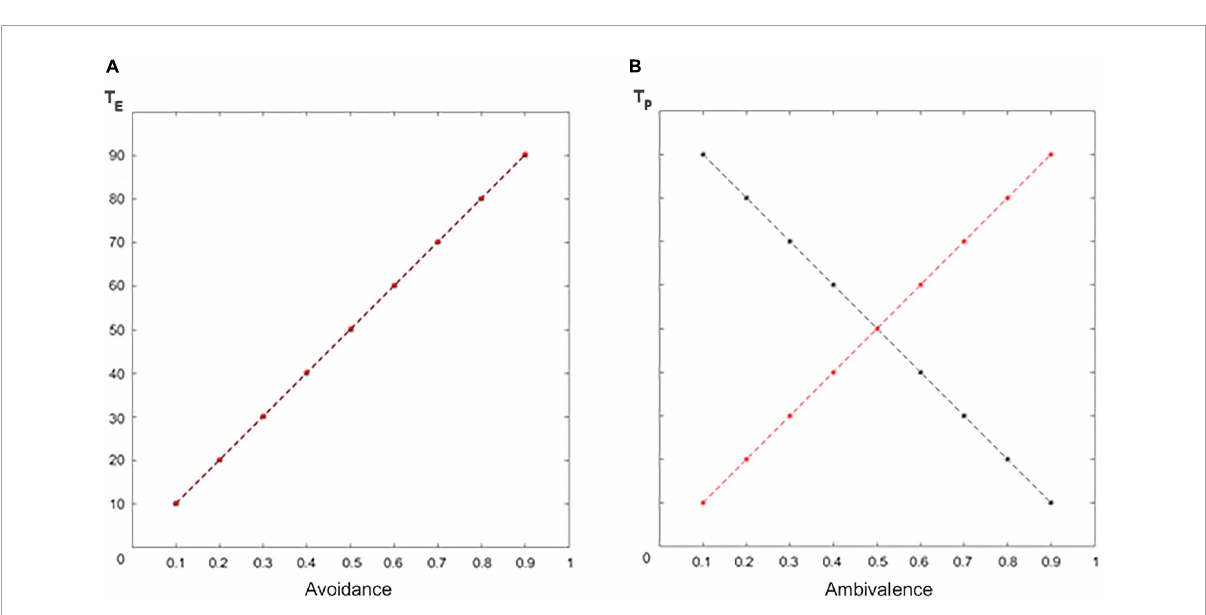
FIGURE6 Dimensional targets. (A) Emotional separation and (B) perceived distance targets (black for the attacher, red for the